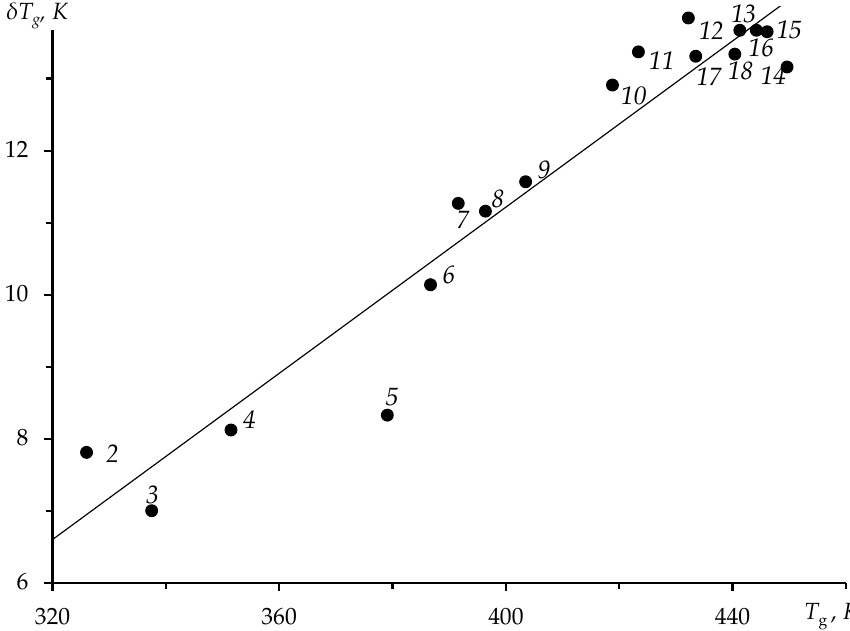
Figure 2. Linear correlation between the temperature interval δ T g characterizing the glass transition range and the glass transition temperature T g of glasses in the As-S system. The point numbers correspond to the glass order numbers in Table 1.